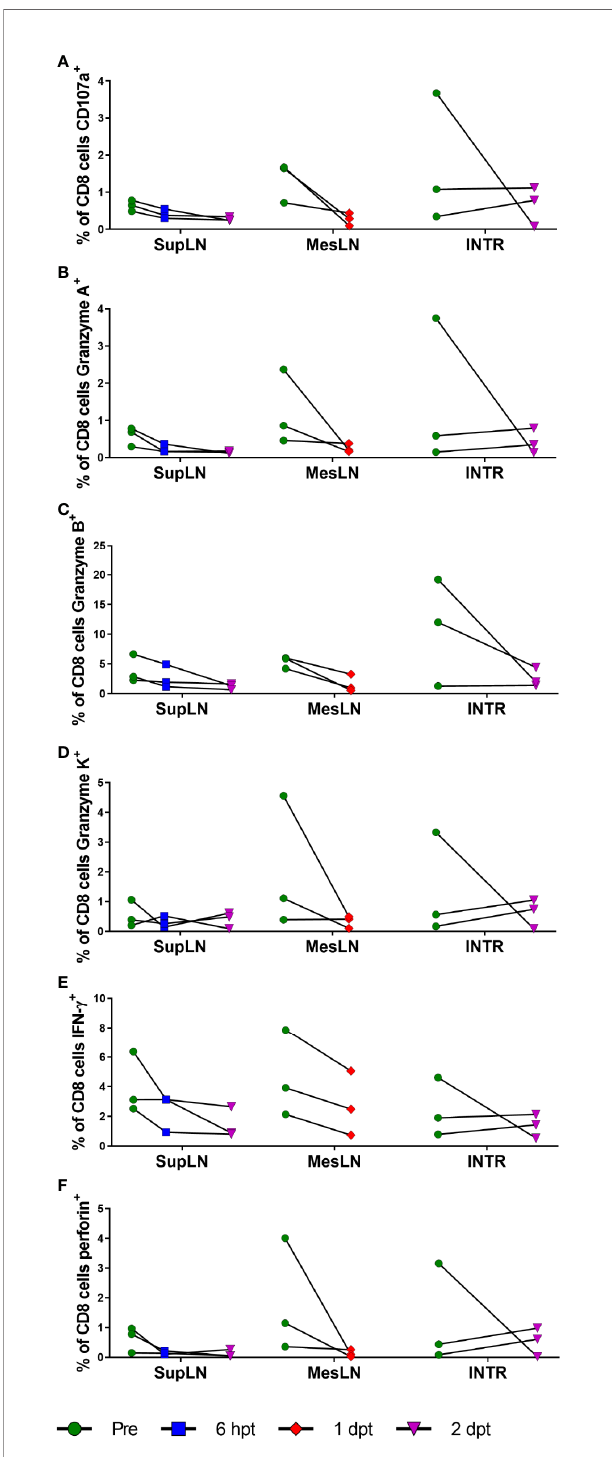
FIGURE 11 | Cytotoxic T lymphocyte function with RMD treatment. Functional assays were performed for cytotoxic T lymphocyte markers of functionality, CD107a (A) , Granzyme A (B) , Granzyme B (C) , Granzyme K (D) , IFN- g (E) , and perforin (F) in CD8 + T cells stimulated with PMA and ionomycin. SupLN, Super fi cial LN; MesLN, Mesenteric LN; INTR, Intestinal